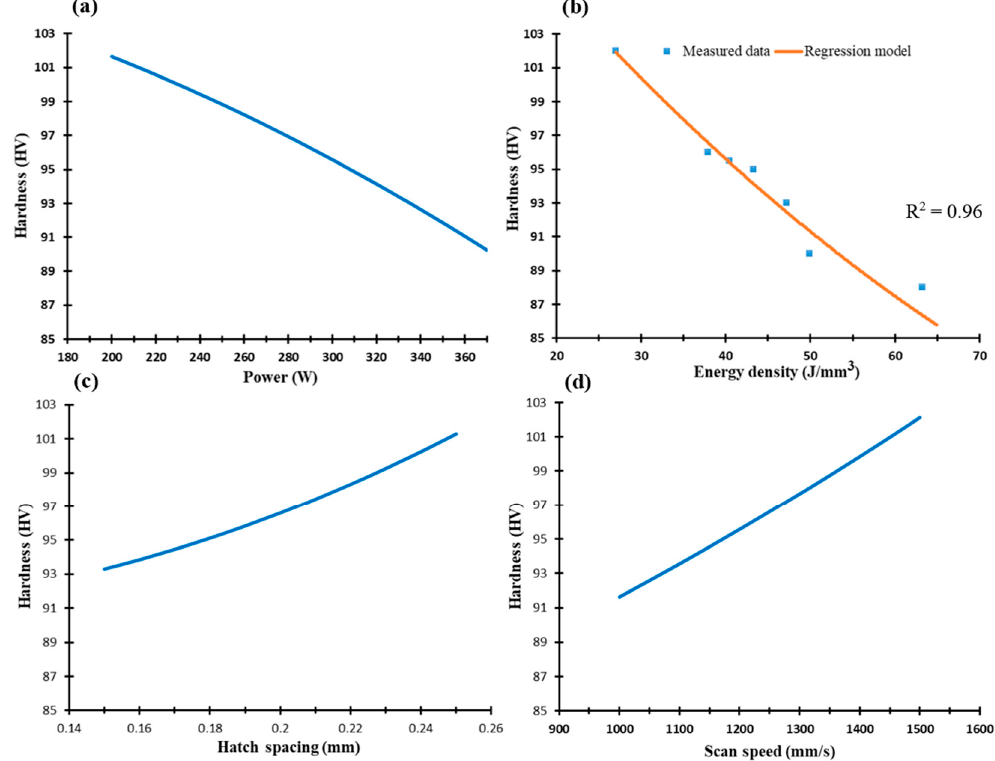
Figure 10. Microhardness of the as-built AlSi10Mg samples along the Z-direction vs. ( a ) Laser power (W); ( b ) Energy density (J/mm 3 ); ( c ) Hatch spacing (mm), and ( d ) Scan speed (mm/s).